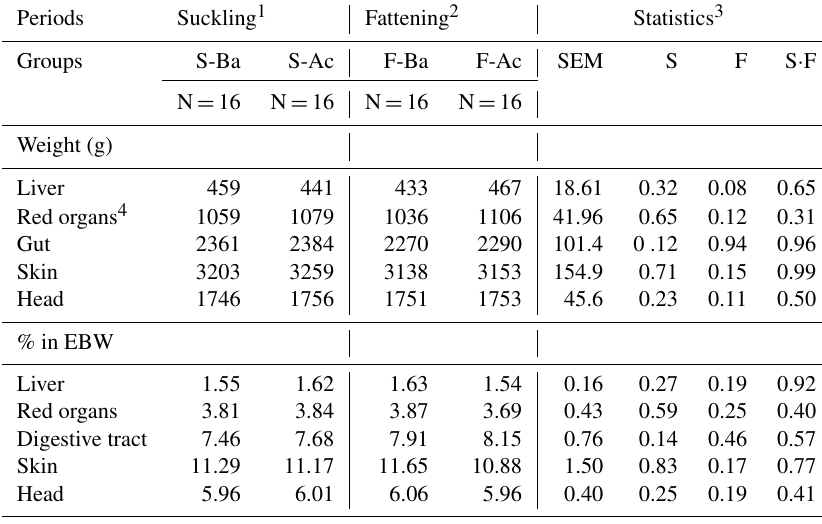
Table 3. Growth and carcass traits of lambs receiving acorn or barley diet. Periods Suckling 1 Fattening 2 Statistics 3 S-Ba S-Ac F-Ba F-Ac SEM S F S · F groups N = 16 N = 16 Initial body weight (BW; kg) Average daily gain (g) Slaughter BW (kg) Empty BW (kg) Carcass weight (kg) Carcass yield (%) Fat thickness (cm) Cost of kg gain (USD)